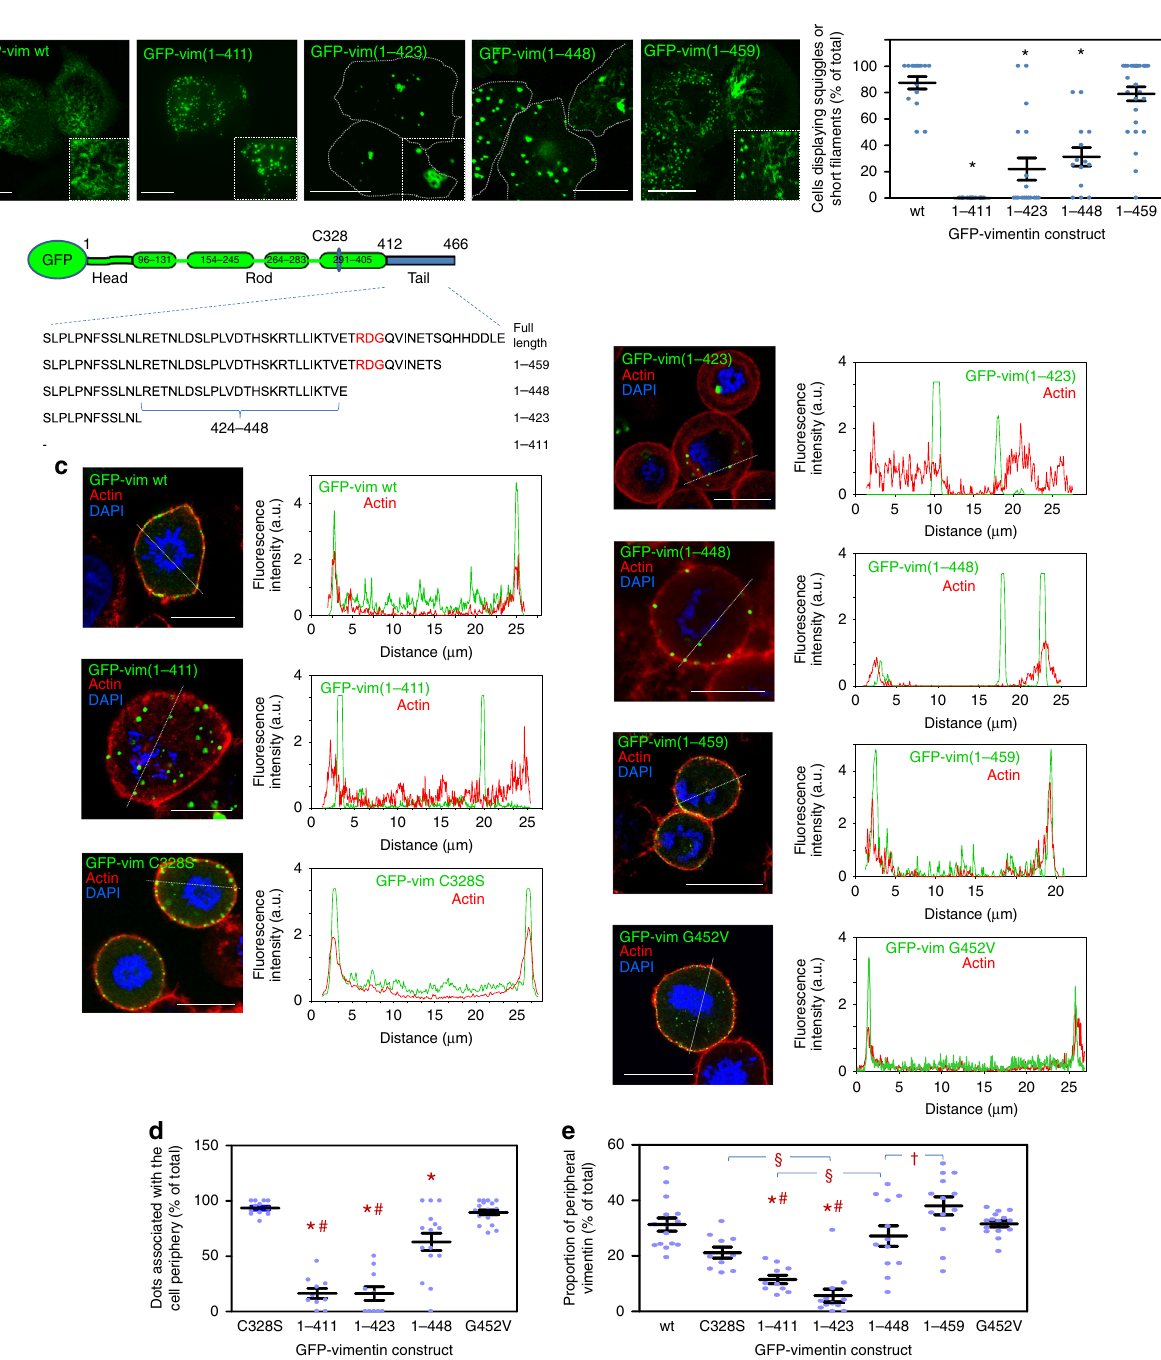
Fig. 8 Assembly and distribution of GFP fusion constructs of truncated vimentin forms. a Live confocal microscopy assessment of the morphology of vimentin assemblies 48 h after transfection of SW13/cl.2 cells with the constructs schematized in panel b . Overall projections are shown. Insets show enlarged areas of interest. The graph (right) depicts the percentage of cells with squiggles or short fi laments for every construct (* p < 10 − 6 vs. wt) by two- tailed, unpaired Student ’ s t -test. c Cells were transfected with the indicated constructs, treated overnight with 0.4 µ M nocodazole in complete medium to increase the proportion of mitotic cells, fi xed, and the distribution of vimentin and f-actin in mitotic cells, assessed. Nuclei were counterstained with DAPI. Single sections taken at mid-cell height are shown in all cases. For every condition, fl uorescence intensity pro fi les for vimentin and f-actin along the dotted lines are shown on the right. d Proportion of vimentin dots associated with the cell periphery for every construct. In this case, GFP-vimentin C328S, which contains an intact tail domain but assembles in dots, is used as a control. GFP-vimentin(1-459) is excluded from this graph due to its organization mainly in squiggles or short fi laments (* p < 0.001 vs. GFP-vimentin C328S and GFP-vimentin G452V; # p < 0.001 vs. GFP-vimentin(1-448) by ANOVA followed by Tukey ’ s post-test for multiple comparisons). e Proportion of peripheral vimentin for all constructs (* p < 0.001 vs. GFP-vimentin wt; § p < 0.01; # p < 0.01 vs GFP-vimentin(1-448) and (1-459); † p < 0.05 by ANOVA followed by Tukey ’ s post-test). The number of determinations for the experimental conditions shown in graphs from left to right was the following: a 15, 15, 18, 20 and 28 fi elds, totaling 162, 55, 77, 97 and 142 cells, respectively; d 12, 10, 10, 15, 19; e 15, 10, 10, 12, 12, 13, 20. Average values ± SEM are shown. Data are provided in the Source Data fi le. Scale bars, 20 μ